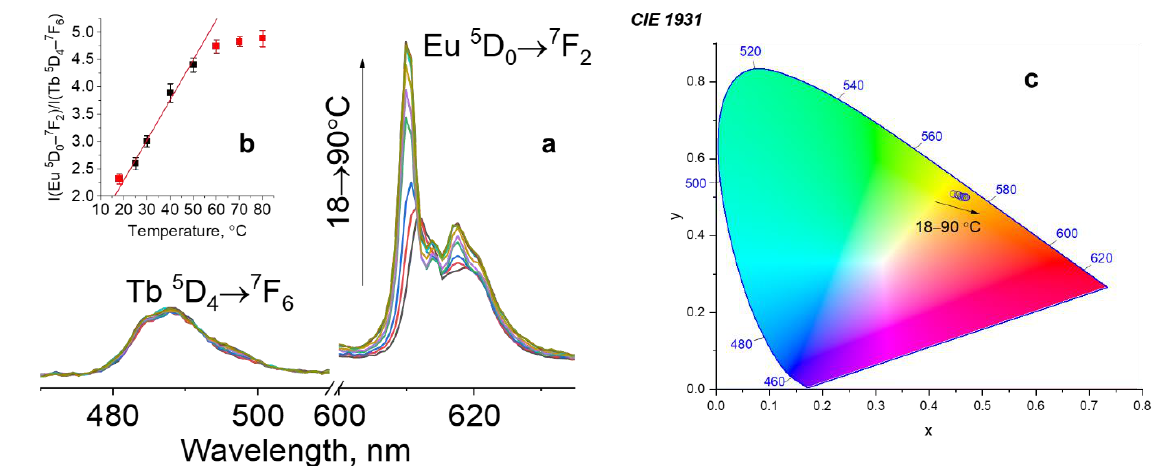
Figure 9. ( a ) Different parts of the emission spectrum (280 nm) and ( b ) temperature dependence of the ratio of luminescence intensities I (Tb 5 D 4 – 7 F 6 )/ I (Eu 5 D 0 – 7 F 2 ) for the (Gd 0.65 Tb 0.33 Eu 0.02 ) 3 (OH) 7 (C 7 H 4 O 5 S)· n H 2 O sample. ( c ) Change in the colour coordinates of (Gd 0.65 Tb 0.33 Eu 0.02 ) 3 (OH) 7 (C 7 H 4 O 5 S)· n H 2 O luminescence with increasing temperature.